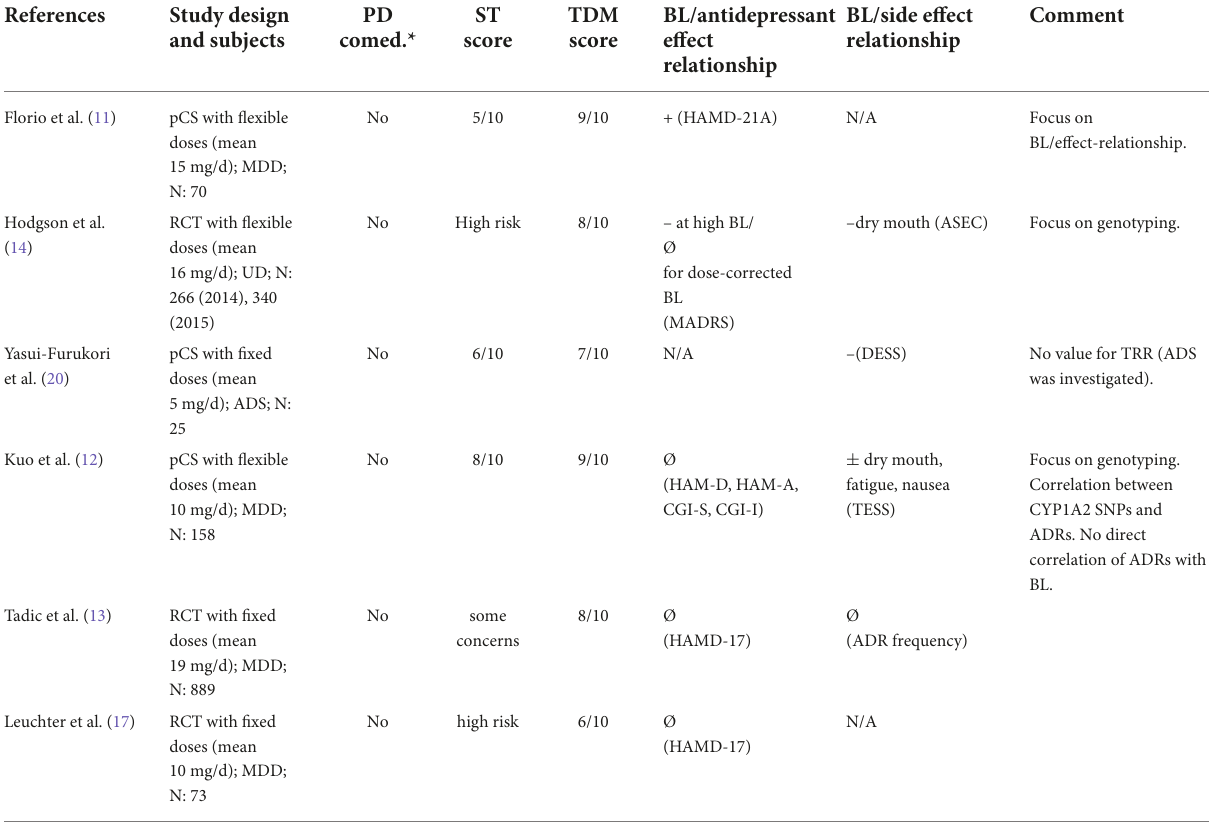
TABLE 1 Studies investigating efficacy and/or side effects of ESC treatment, sorted by relevance.